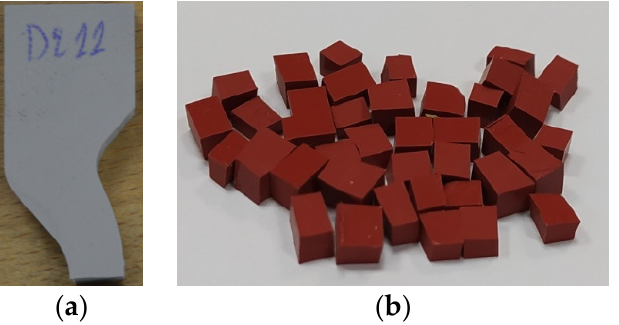
Figure 3. Test pieces for the density measurement from the sheds of composite insulators for ( a ) method A and ( b ) method B of the standard ISO 2781 [14].